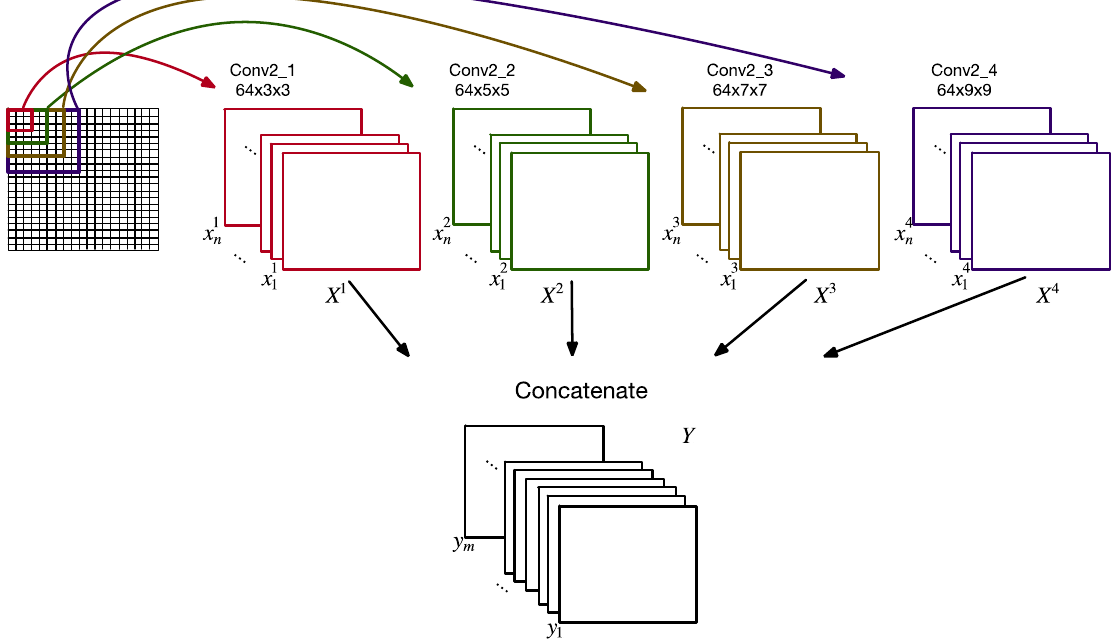
Figure 6. The multi-scale (MS) layer includes four di ff erent scale convolutions. X 1 , X 2 , X 3 , X 4 are the feature maps from the di ff erent scale convolutions, and Y represents the concatenated multi-scale feature maps.